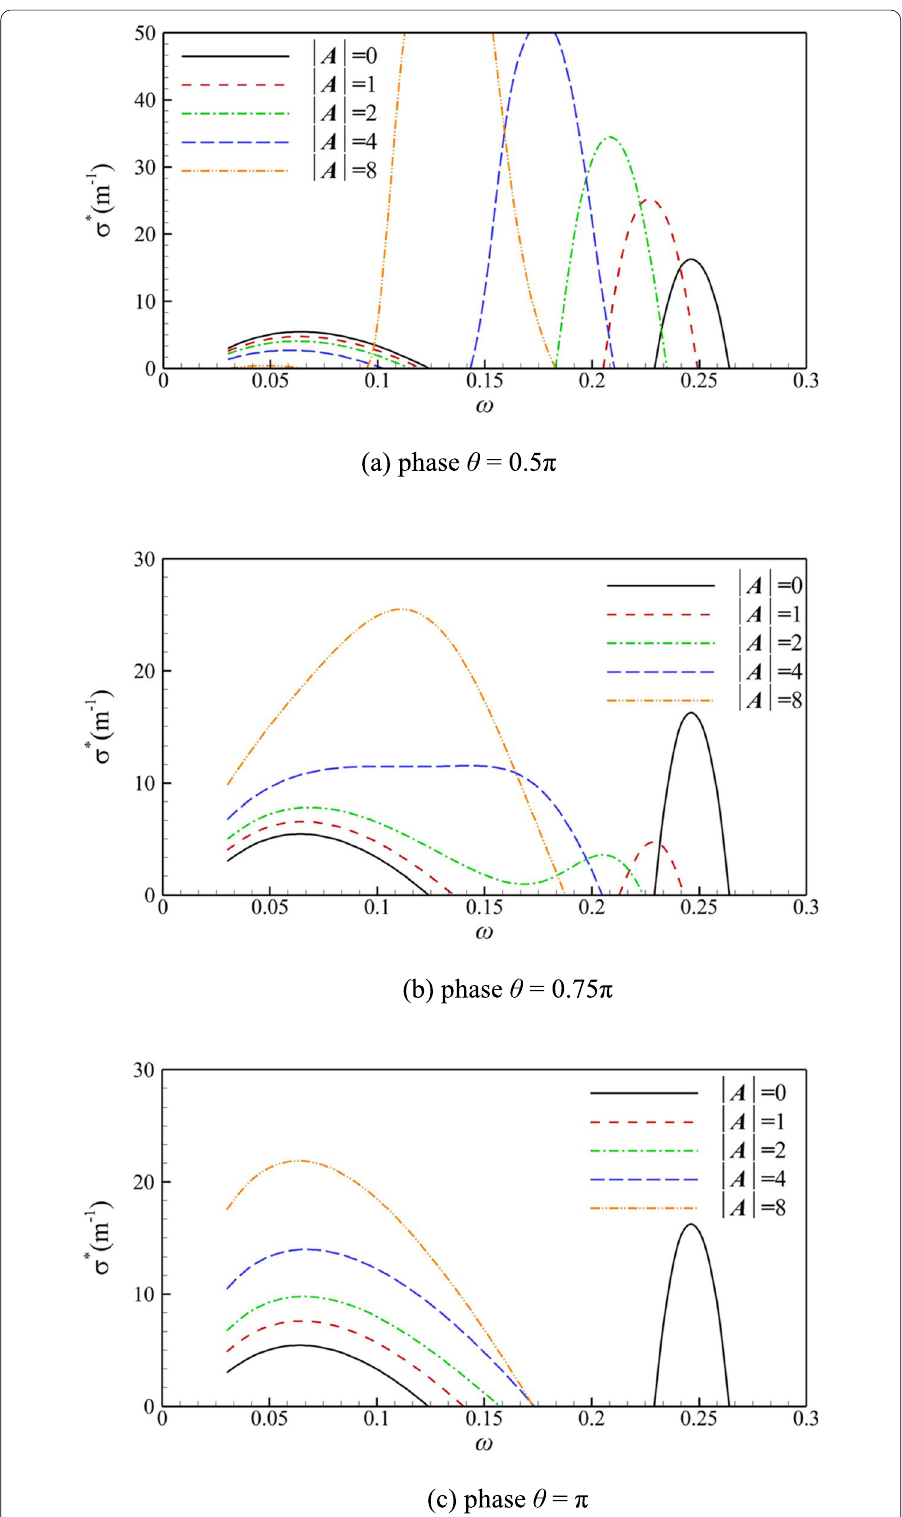
Fig. 4 Effects of the admittance phase and amplitude of the acoustic metasurface on the growth rates of unstable modes (| A | 0 corresponds to the smooth wall). ( a ) phase θ = θ =